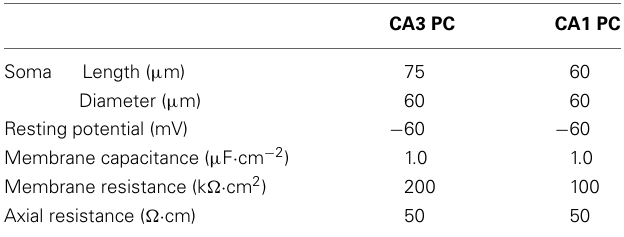
Table 1 | Morphology and passive membrane properties of CA3 and CA1 pyramidal cell (PC) models.